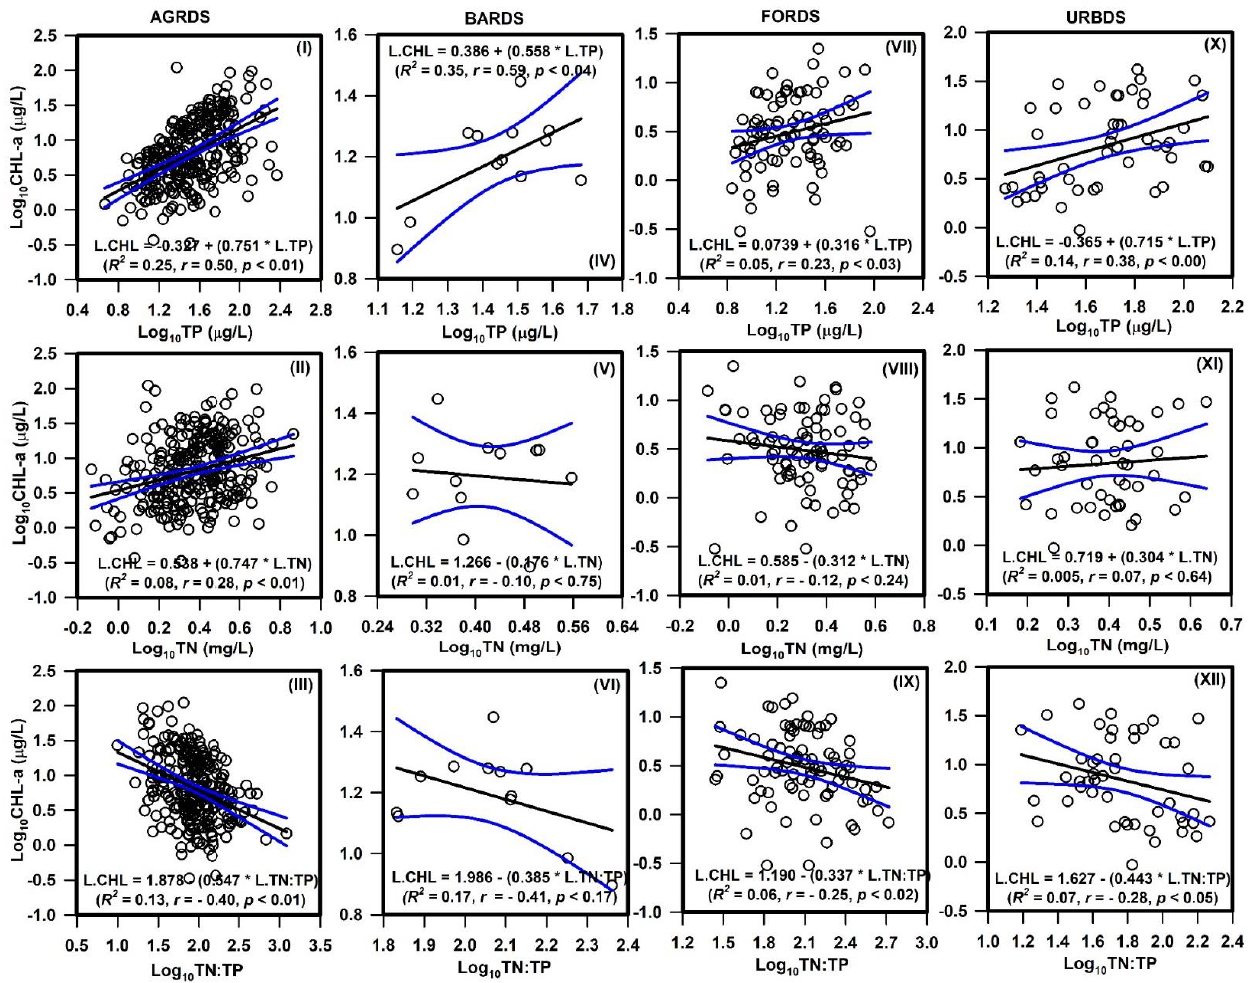
Figure 5. Influence of total phosphorus (TP), total nitrogen (TN), and TN:TP ratios on algal chloro- phyll (CHL-a) in the Nakdong River basin. (AGRDS: agricultural coverage-dominated sites — ( I – III ), BARDS: barren coverage-dominated sites — ( IV – VI ), FORDS: forest coverage-dominated